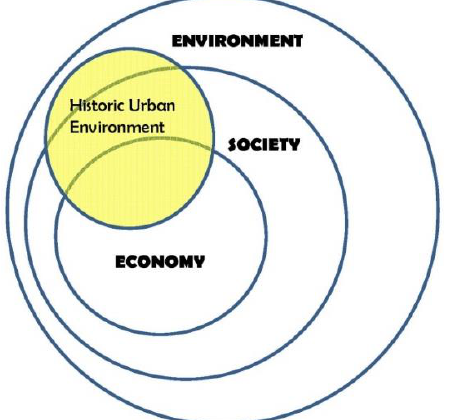
Figure 2. Location of historic environment in the overlapping Russian Doll model (Author,